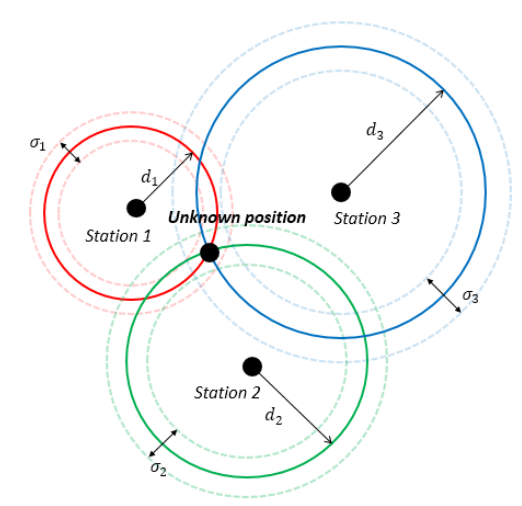
Figure 1. Circular lateration